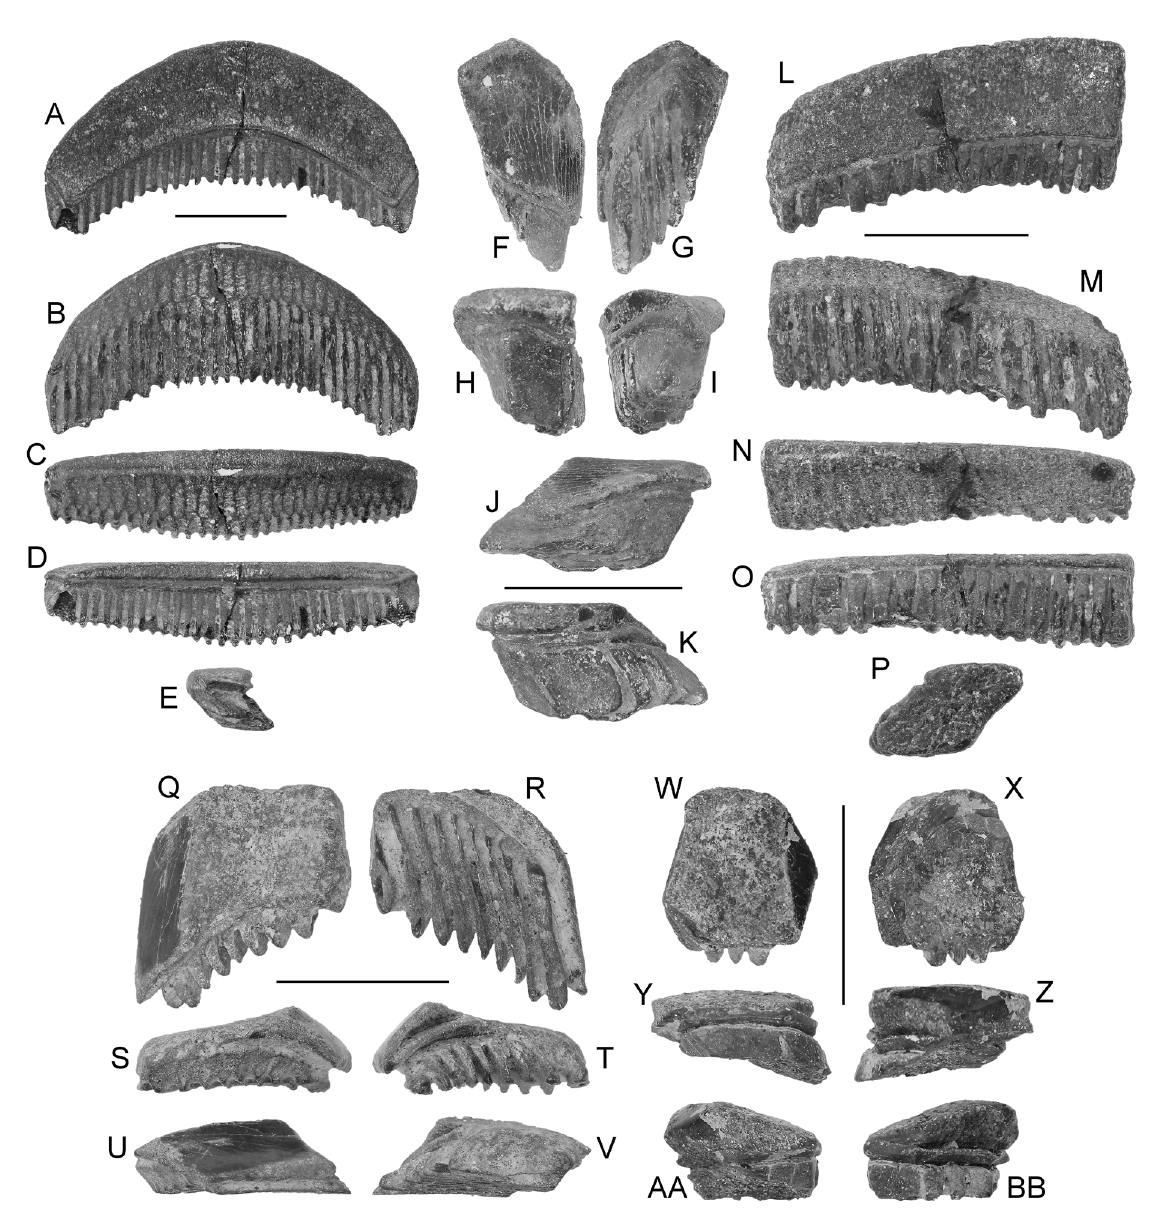
Fig. 49. Pseudaetobatus belli Cicimurri & Ebersole, 2015, teeth. A–E . MSC 35048, holotype, lower median tooth, lower Tallahatta Formation. A . Oral view. B . Basal view. C . Labial view. D . Lingual view. E . Profile view. F–K . MSC 35054, paratype, lower right distal–most lateral tooth, lower Tallahatta Formation. F . Oral view. G . Basal view. H . Labial view. I . Lingual view. J . Distal view. K . Mesial view. L–P . MSC 35058, paratype, upper? median tooth, lower Tallahatta Formation. L . Oral view. M . Basal view. N . Labial view. O . Lingual view. P . Profile view. Q–V . MSC 35059, paratype, upper right distal– most lateral tooth, lower Tallahatta Formation. Q . Oral view. R . Basal view. S . Labial view. T . Lingual view. U . Distal view. V . Mesial view. W–BB . MSC 35062, paratype, intermediate lateral tooth, lower Tallahatta Formation. W . Oral view. X . Basal view. Y . Distal view. Z . Mesial view. AA . Labial view. BB . Lingual view. Scale bars = 1